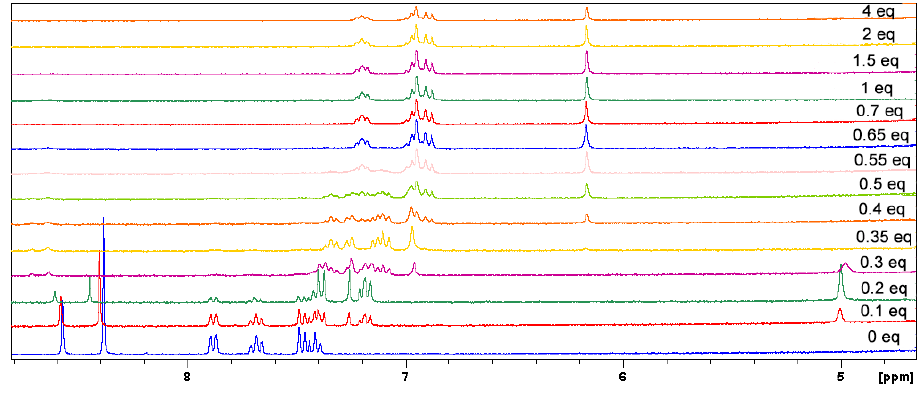
Figure 2. 1 H-NMR (400 MHz, (CD 3 ) 2 SO) titration of L 12 − (triethylammonium salt) with Eu 3+ (D 2 O solution of chloride hexahydrate salt).